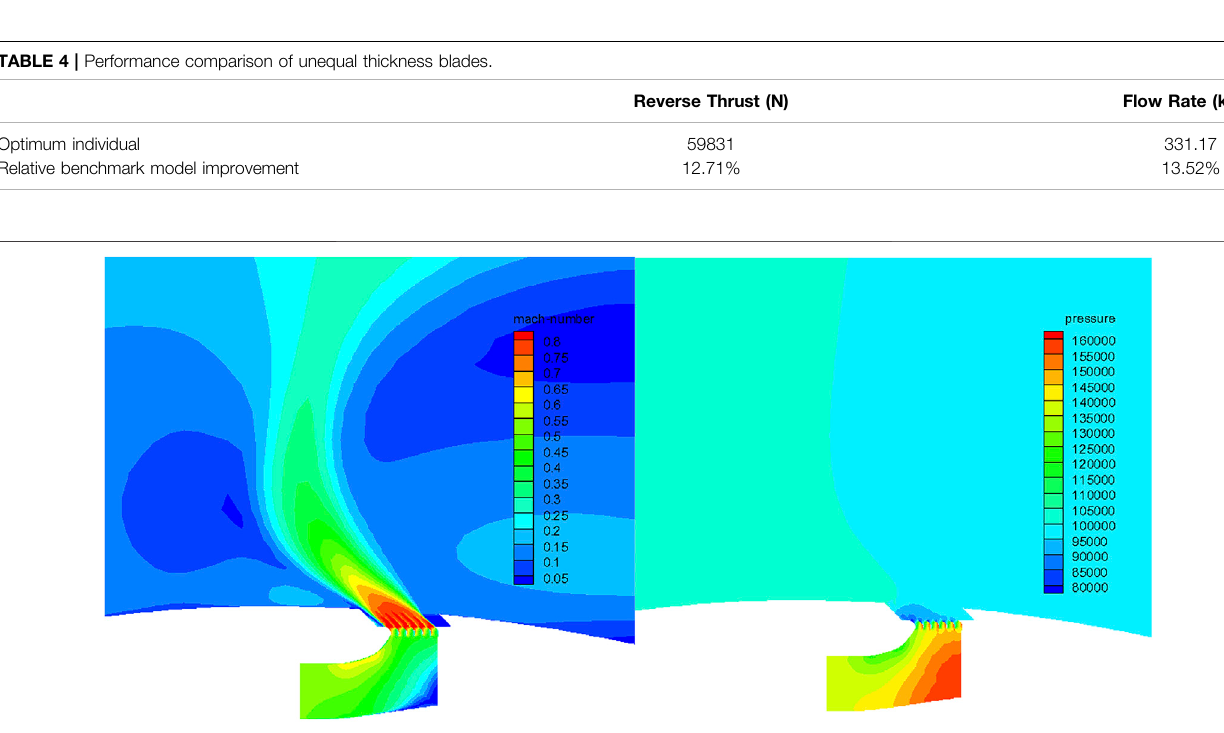
TABLE 4 | Performance comparison of unequal thickness blades.